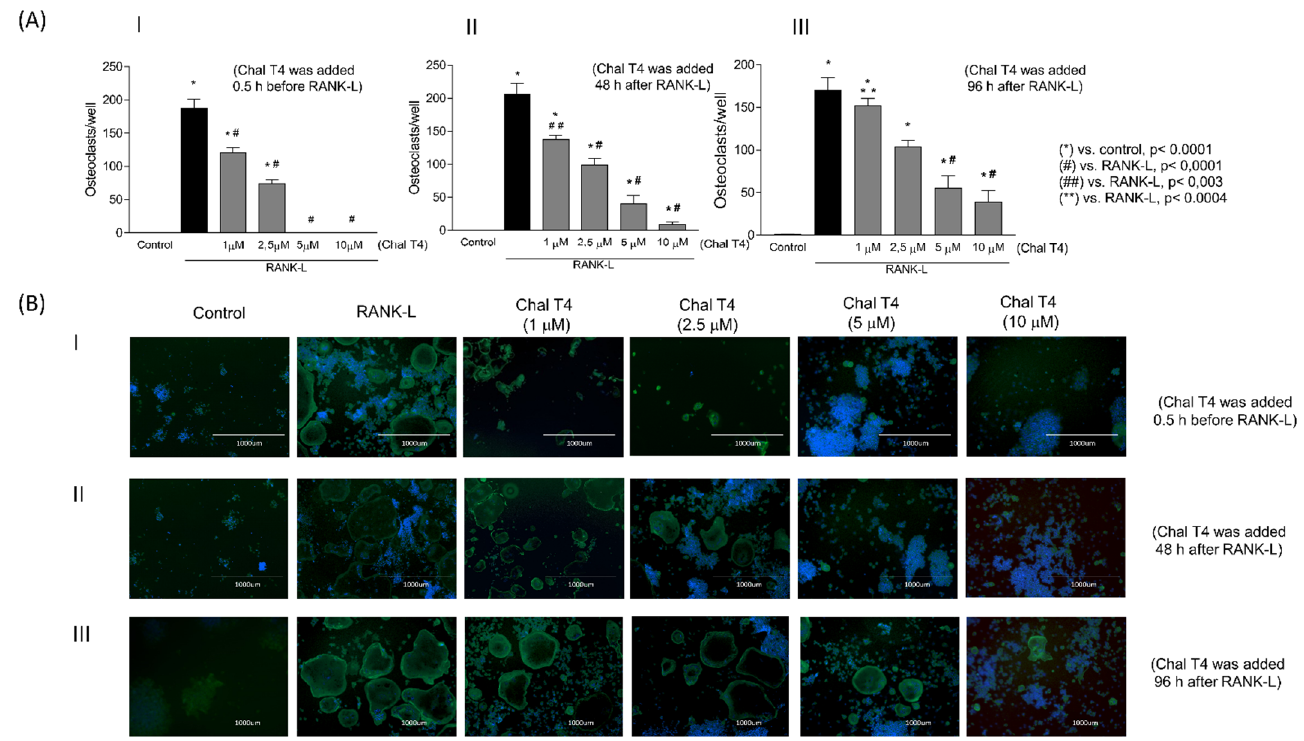
Figure 1. Chalcone T4 reduces osteoclast differentiation in a dose-dependent manner, even when added up to 96 h after RANKL stimulation. Cells were seeded and stimulated with RANKL (100 ng/mL) and/or treated with di ff erent concentrations of Chalcone T4. In ( A ) The bar graph represents the number of osteoclasts per well after stimulation with RANKL, and treatment with Chalcone at di ff erent times (( I ): 30 min before stimulation with RANKL, ( II ): 48 h and ( III ): 96 h after stimulation). In ( B ) Images obtained in fl uorescence microscopy (4× magni fi cation), representative of the di ff erentiation of osteoclasts induced by RANKL, after treatment or not of cells with Chalcone T4. The bars indicate the mean values and the vertical lines the standard error of the mean (SEM) of three independent experiments, performed in duplicate. p values are depicted in the fi gure.